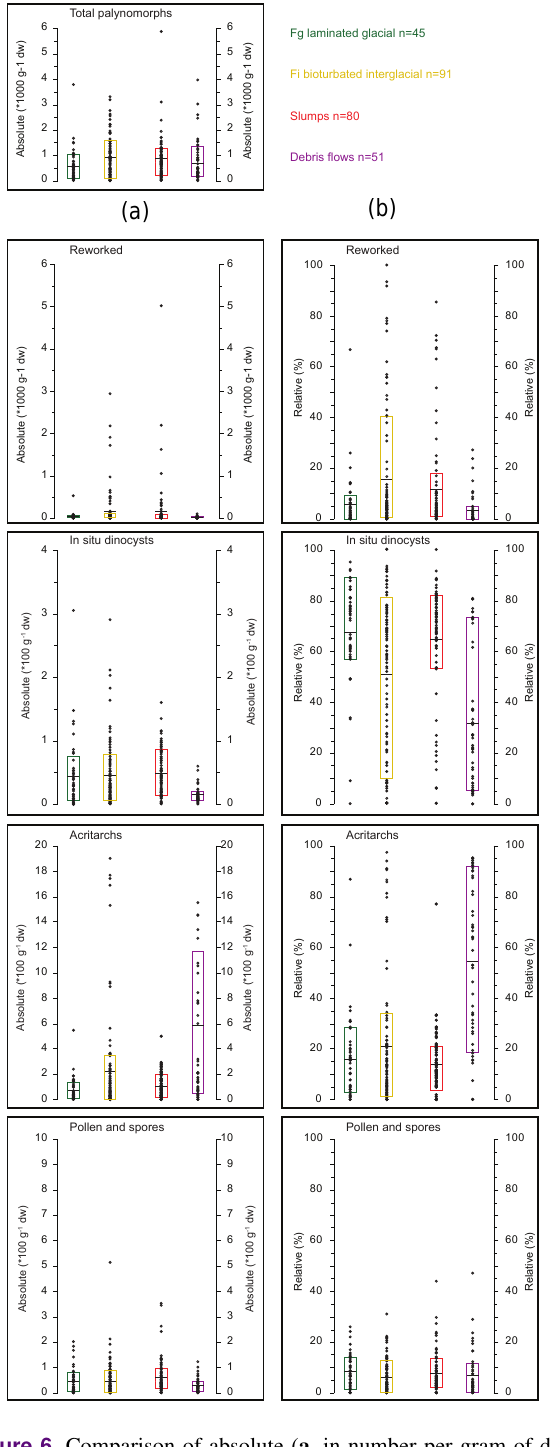
Figure 6. Comparison of absolute ( a , in number per gram of dry weight) and relative ( b ; in percent of total palynomorphs) abun- dances of palynomorph groups per lithology for Hole U1356A. Av- erage (black lines) and 17–83% percentile (coloured bar) of ab- solute and relative abundances of total palynomorphs, reworked dinocysts, in situ dinocysts, acritarchs and terrestrial palynomorphs grouped for the different facies (Salabarnada et al.,